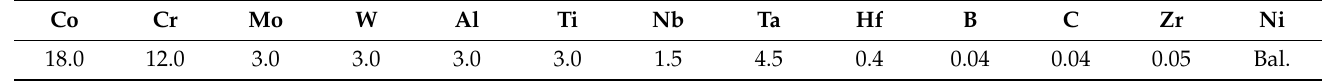
Table 1. Nominal composition (wt.%) of the novel PM